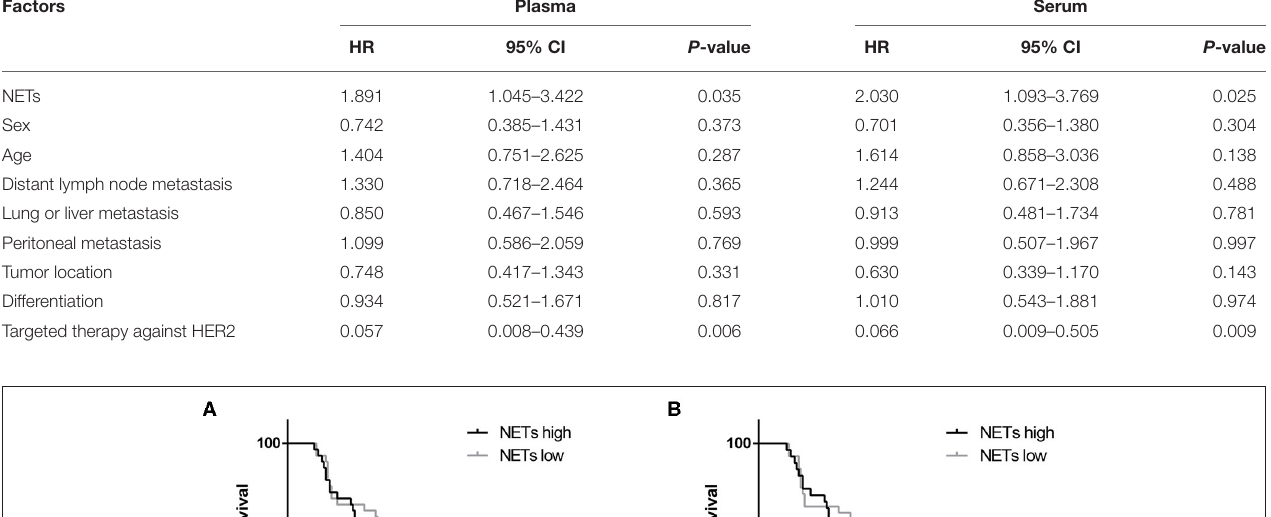
TABLE 8 | Multivariate analysis of factors according to PFS in GC patients who had received advanced first-line treatment. Factors